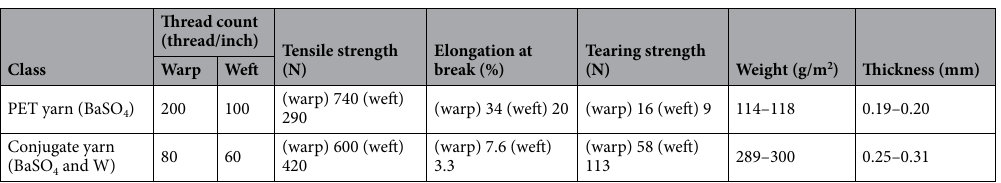
Table 3. Properties of the produced fabrics.